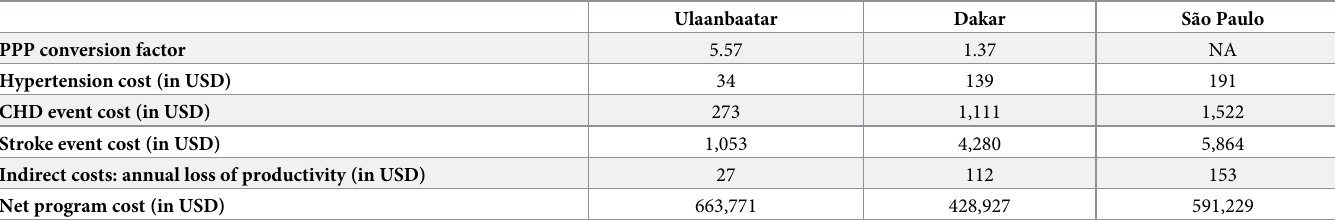
Table 2. Cost assumptions. This table summarizes the cost assumptions made for Ulaanbaatar, Dakar, and S ã o Paulo. PPP = Purchasing power